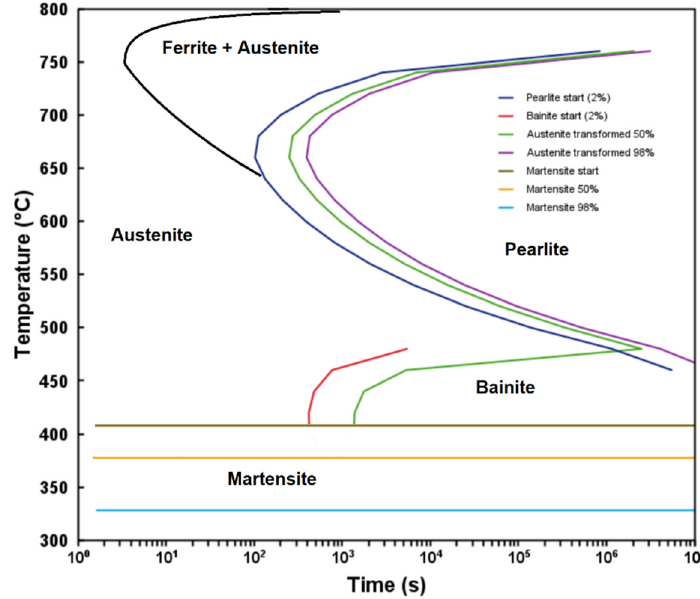
Figure 2. TTT diagram of the steel.